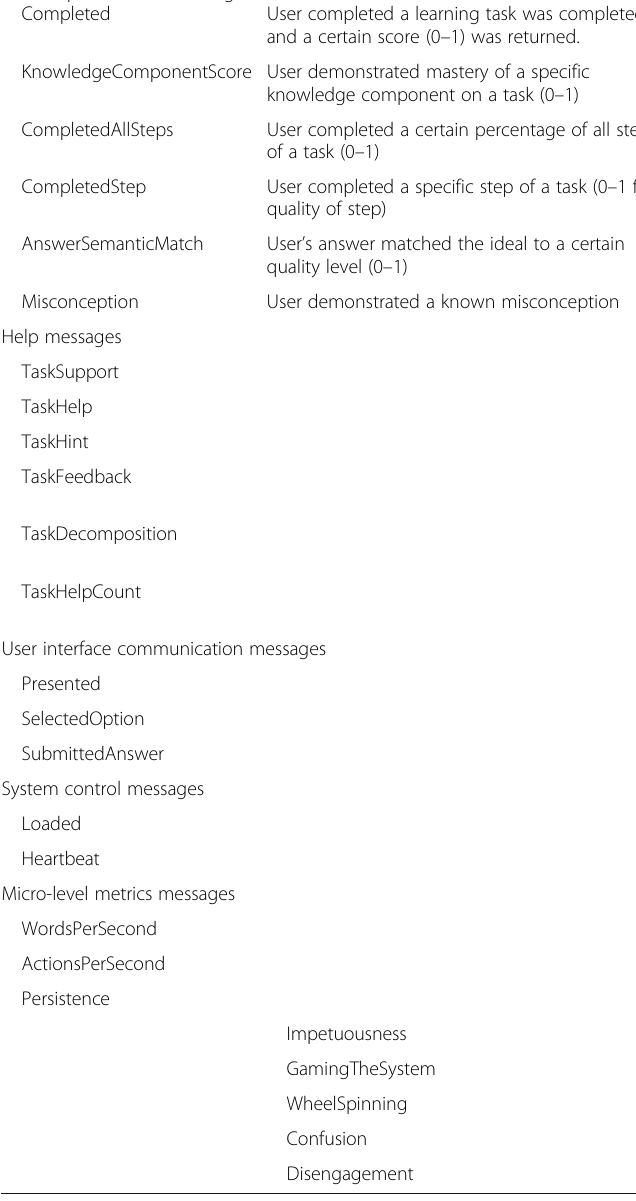
Table 1 Inventory of ITS messages aggregated from ITS design teams Learner performance messages